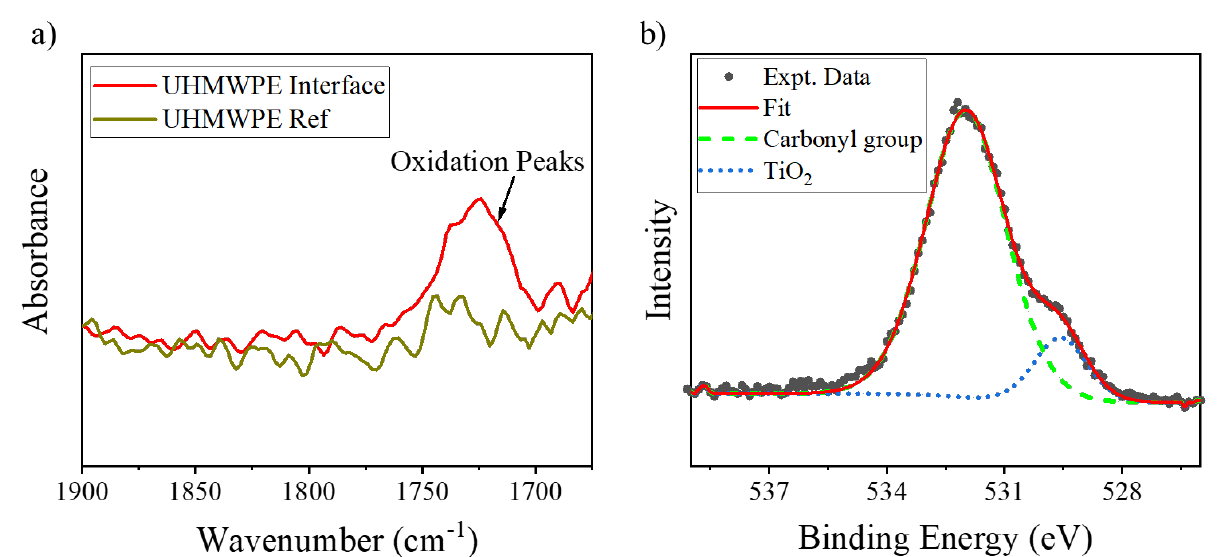
Figure 11. ( a ) FTIR results showing an additional peak after hot pressing, corresponding to the carbonyl groups (UHMWPE interface was from the top surface of the UHMWPE side of the fractured joint); ( b ) XPS spectra (O 1s) collected from the top surface of the TC4 side of the fractured joint.